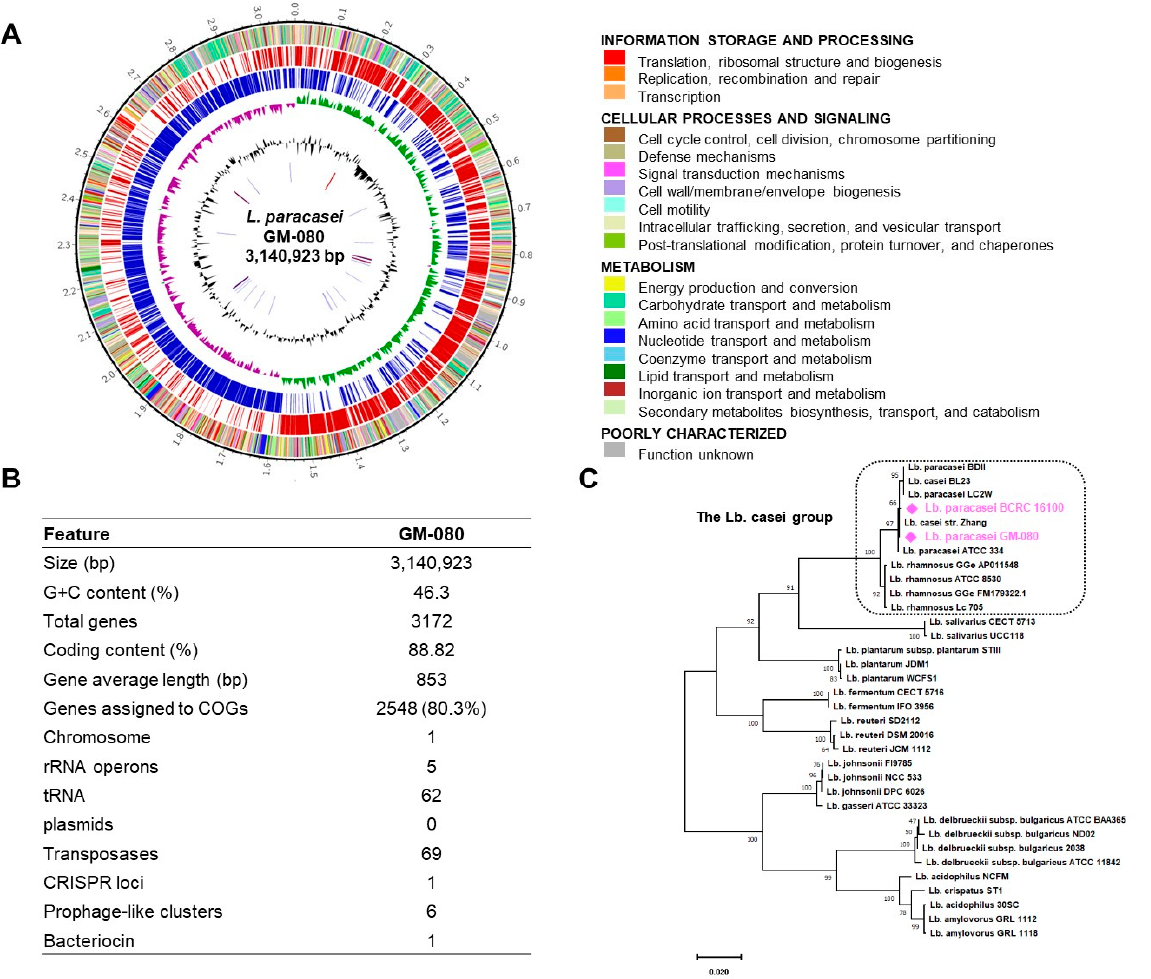
Figure 3. WGS analysis of GM-080. ( A ) Circular genome graph of GM-080 illustrated using Circos. ( B ) Summary of general features of GM-080 genome. ( C ) Maximum-likelihood tree of GM-080 and BCRC 16100 with 32 other known Lactobacillus strains.